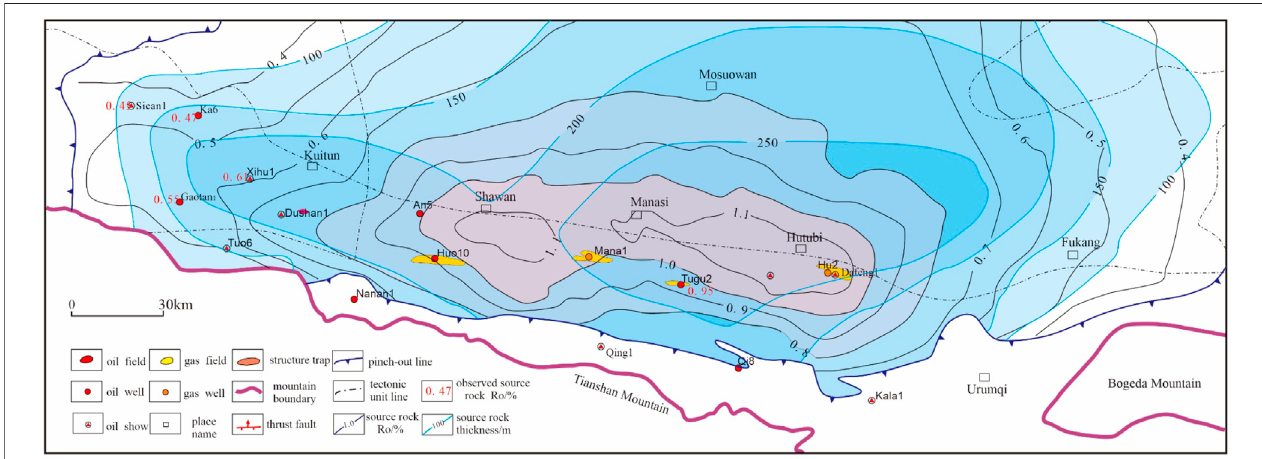
FIGURE 12 | Map showing the Cretaceous source rock maturity and thickness in the South Junggar Basin. The measured Ro of some wells is shown in the map.